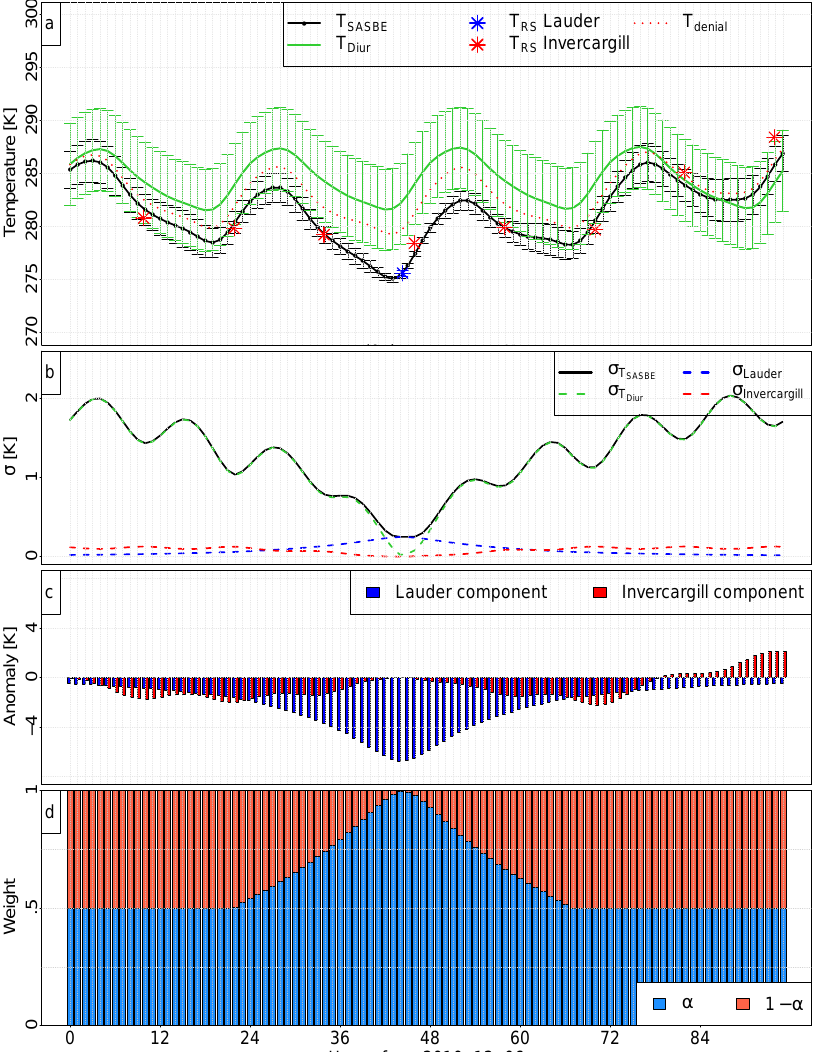
Figure 4. Temperature SASBE at 925hPa and its individual components for 6 to 9 December 2010. (a) Temperature SASBE (black line), diurnal cycle (green line), denial study (i.e. pretending no measurements exist at Lauder, dotted red line), and radiosonde temperature measurement if available (Invercargill: red star; Lauder: blue star). (b) Uncertainty components from Eq. (17), i.e. uncertainty added by: the diurnal cycle (red), the Lauder radiosonde anomaly (blue), and the estimated Lauder anomaly (red). The combined uncertainty ( σ T is shown as black line. (c) Weighted Lauder radiosonde temperature anomaly ( P N